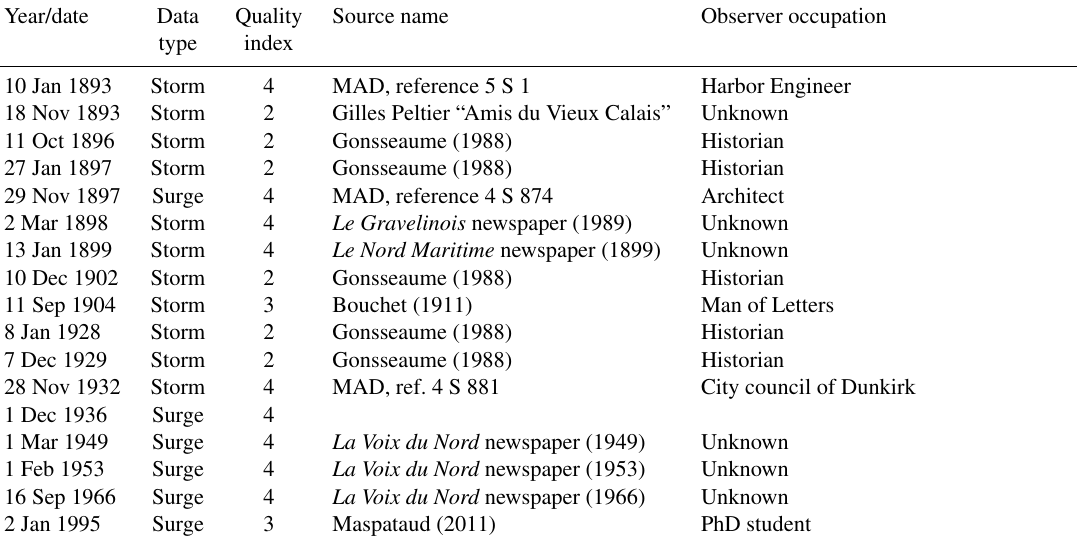
Fig. 1b on an old map of Dunkirk city. The difference